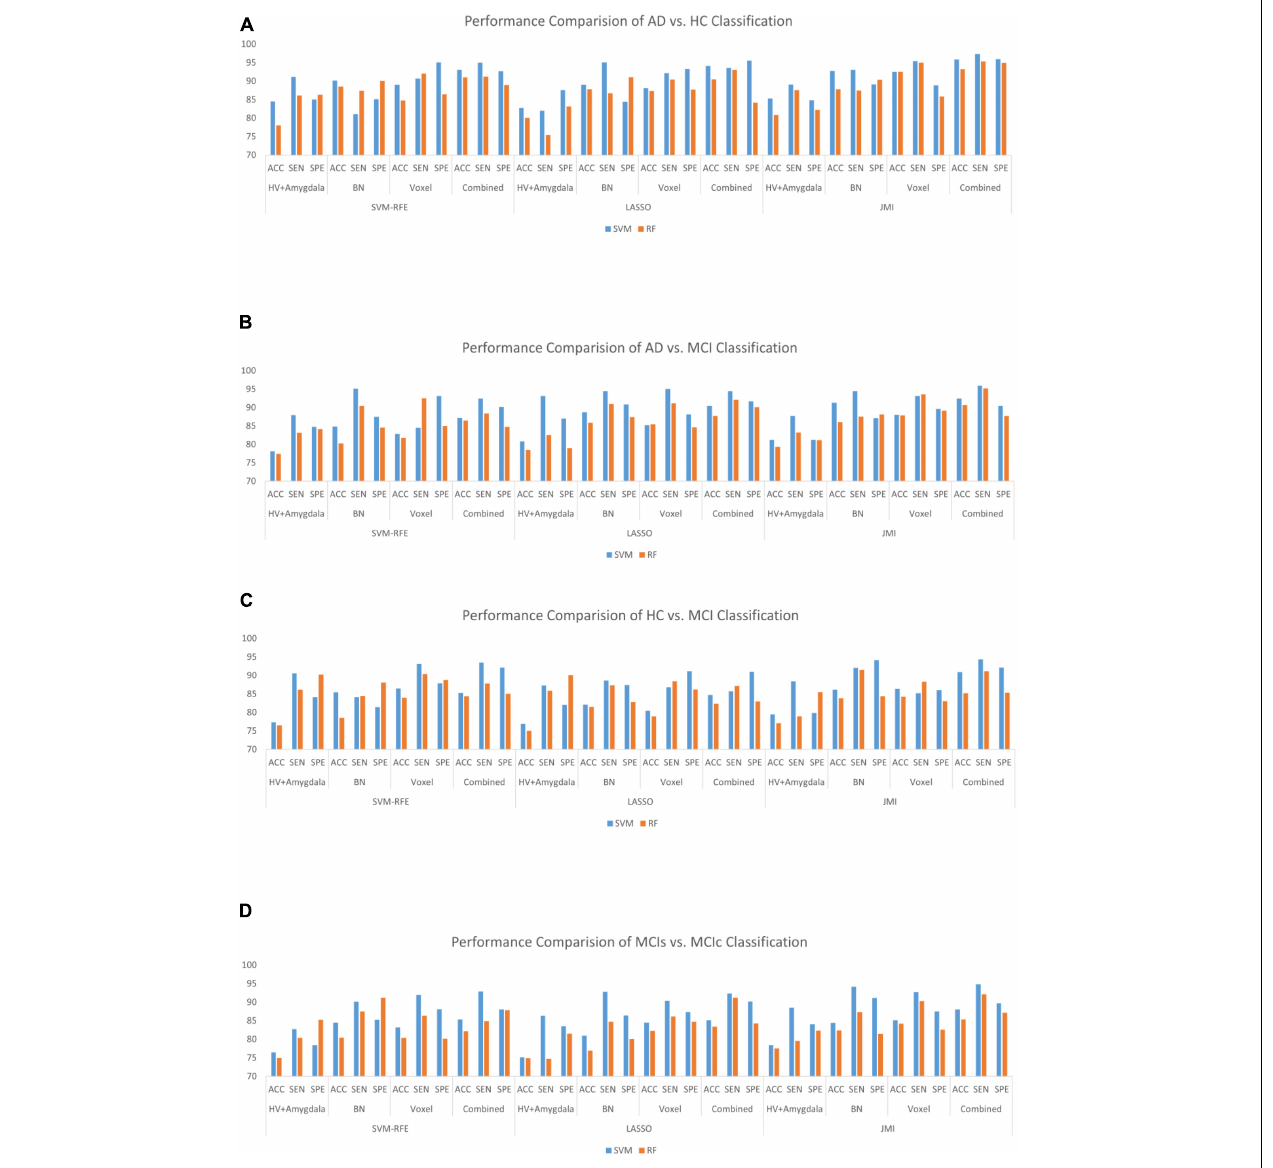
FIGURE 11 | Bar graph with different features selection methods (A) the AD vs. HC group, (B) the AD vs. MCI group, (C) the HC vs. MCI group, and (D) the MCIs vs. MCIc group on different feature vectors: Hippocampal-amygdala volume, Brain Network (BN), Voxel, and combined features